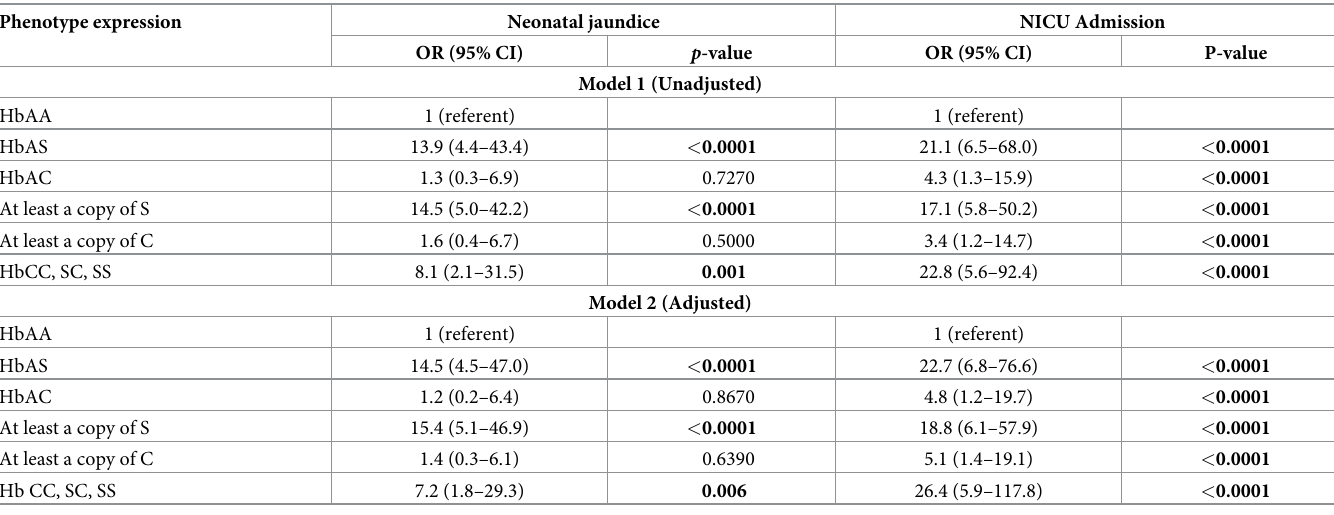
Table 4. Association between foetal outcomes and haemoglobin variants.